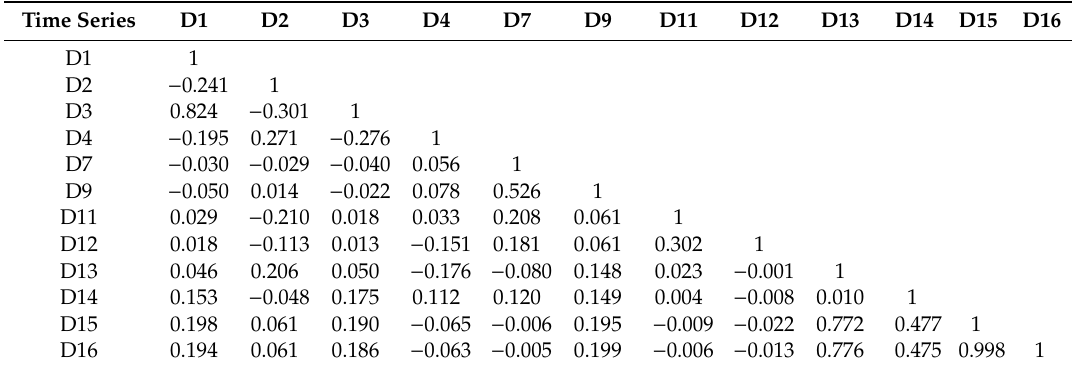
Table 8. Correlation Matrix: Greece–Italy interconnection (2015–2018).